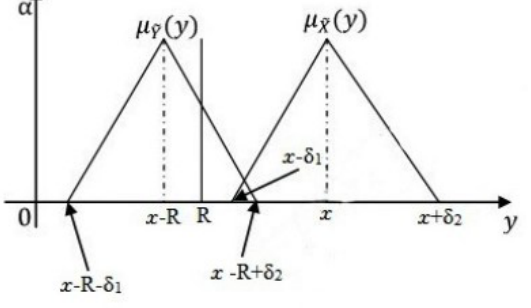
Figure 2. Membership function of the fuzzy shortage quantity when R + δ 1 ≤ x